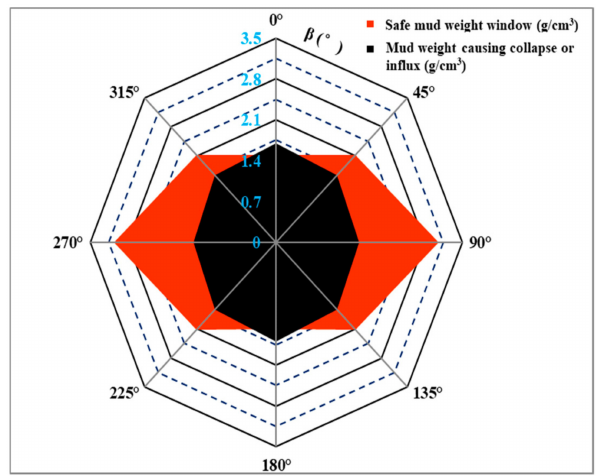
Figure 10. Safe mud weight window of the target zone with ∆ p p / p p = 0.6.